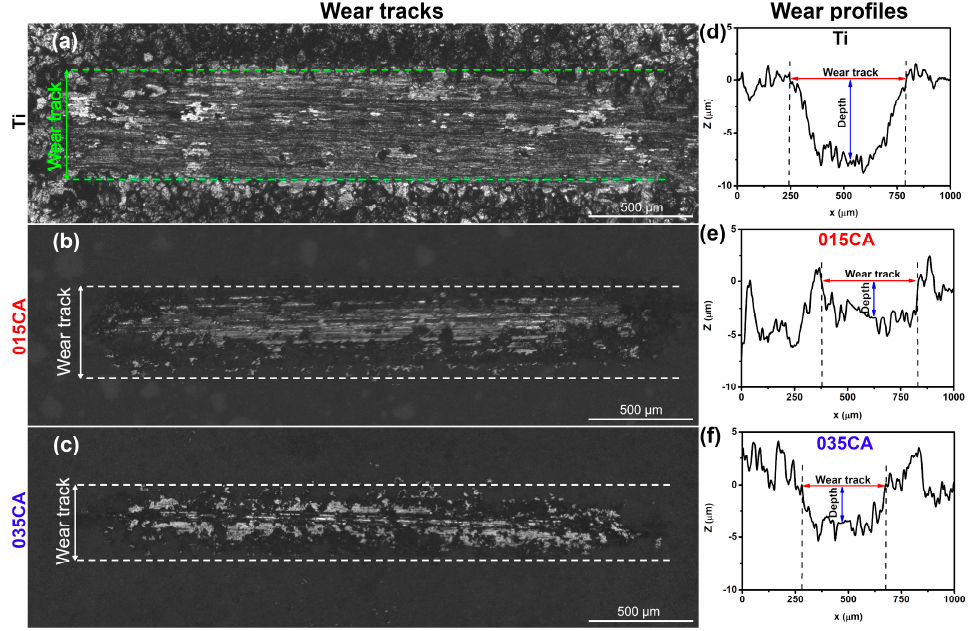
Figure 4. Optical microscope images of the worn surfaces for ( a ) Ti, ( b ) 015CA and ( c ) 035CA and wear − track profiles of the worn surfaces for ( d ) Ti, ( e ) 015CA and ( f ) 035